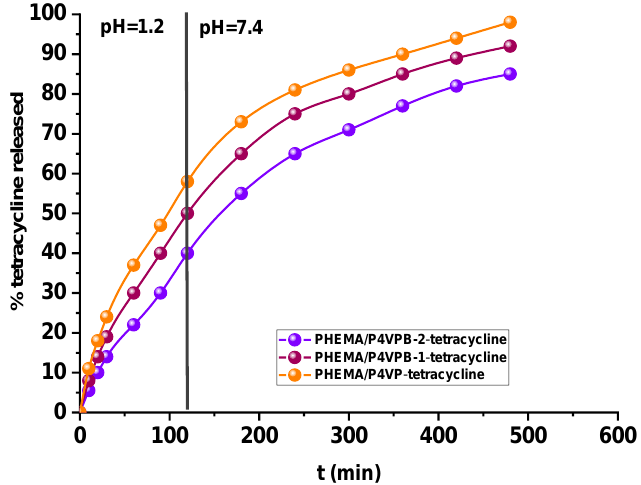
Figure 13. Release profile of tetracycline from semi-IPN–drug systems. Table 3. Kinetic parameters of tetracycline release process from semi-IPN–drug systems.